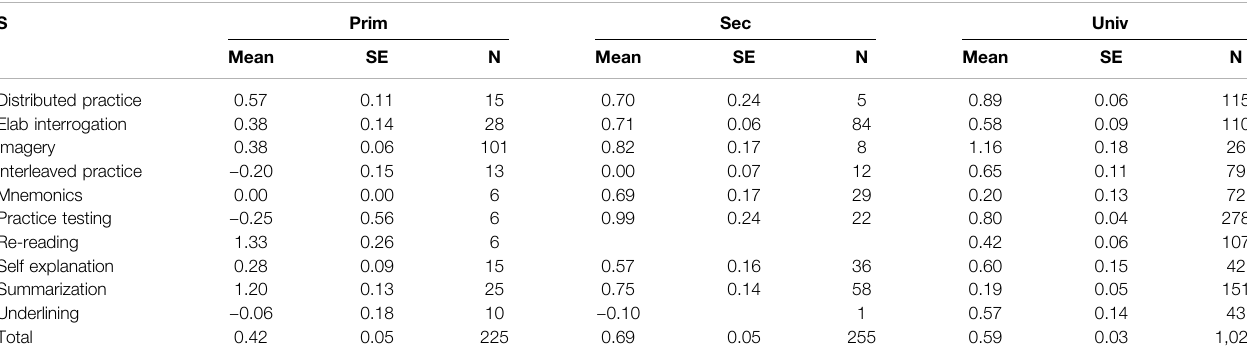
TABLE 3 | Effect sizes moderated by grade